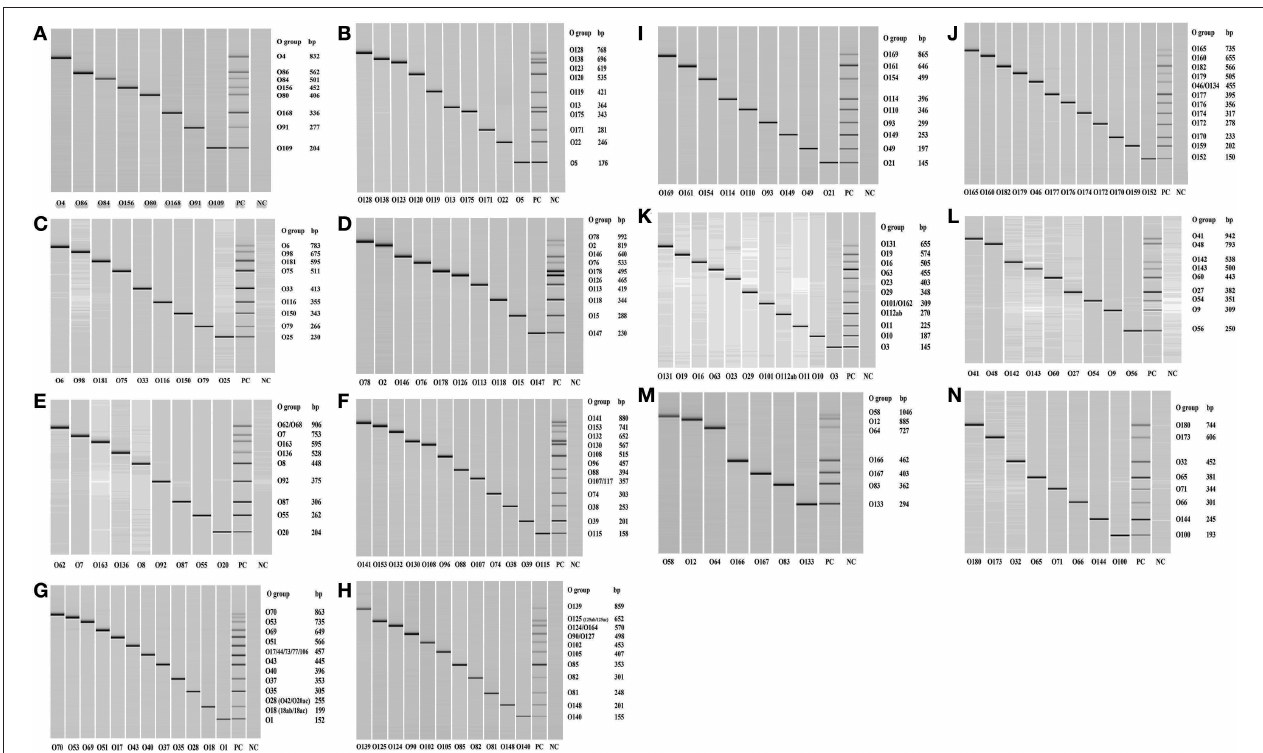
FIGURE 1 | QIAxcel images of the amplicons of serogroup-specific genes of 137 serogroups of Shiga toxin-producing Escherichia coli amplified by 14 sets (A–N) of multiplex PCR assays. Positive control (PC) included pooled cultures of the known serogroups within each assay. Negative control (NC) included all reagents except the DNA